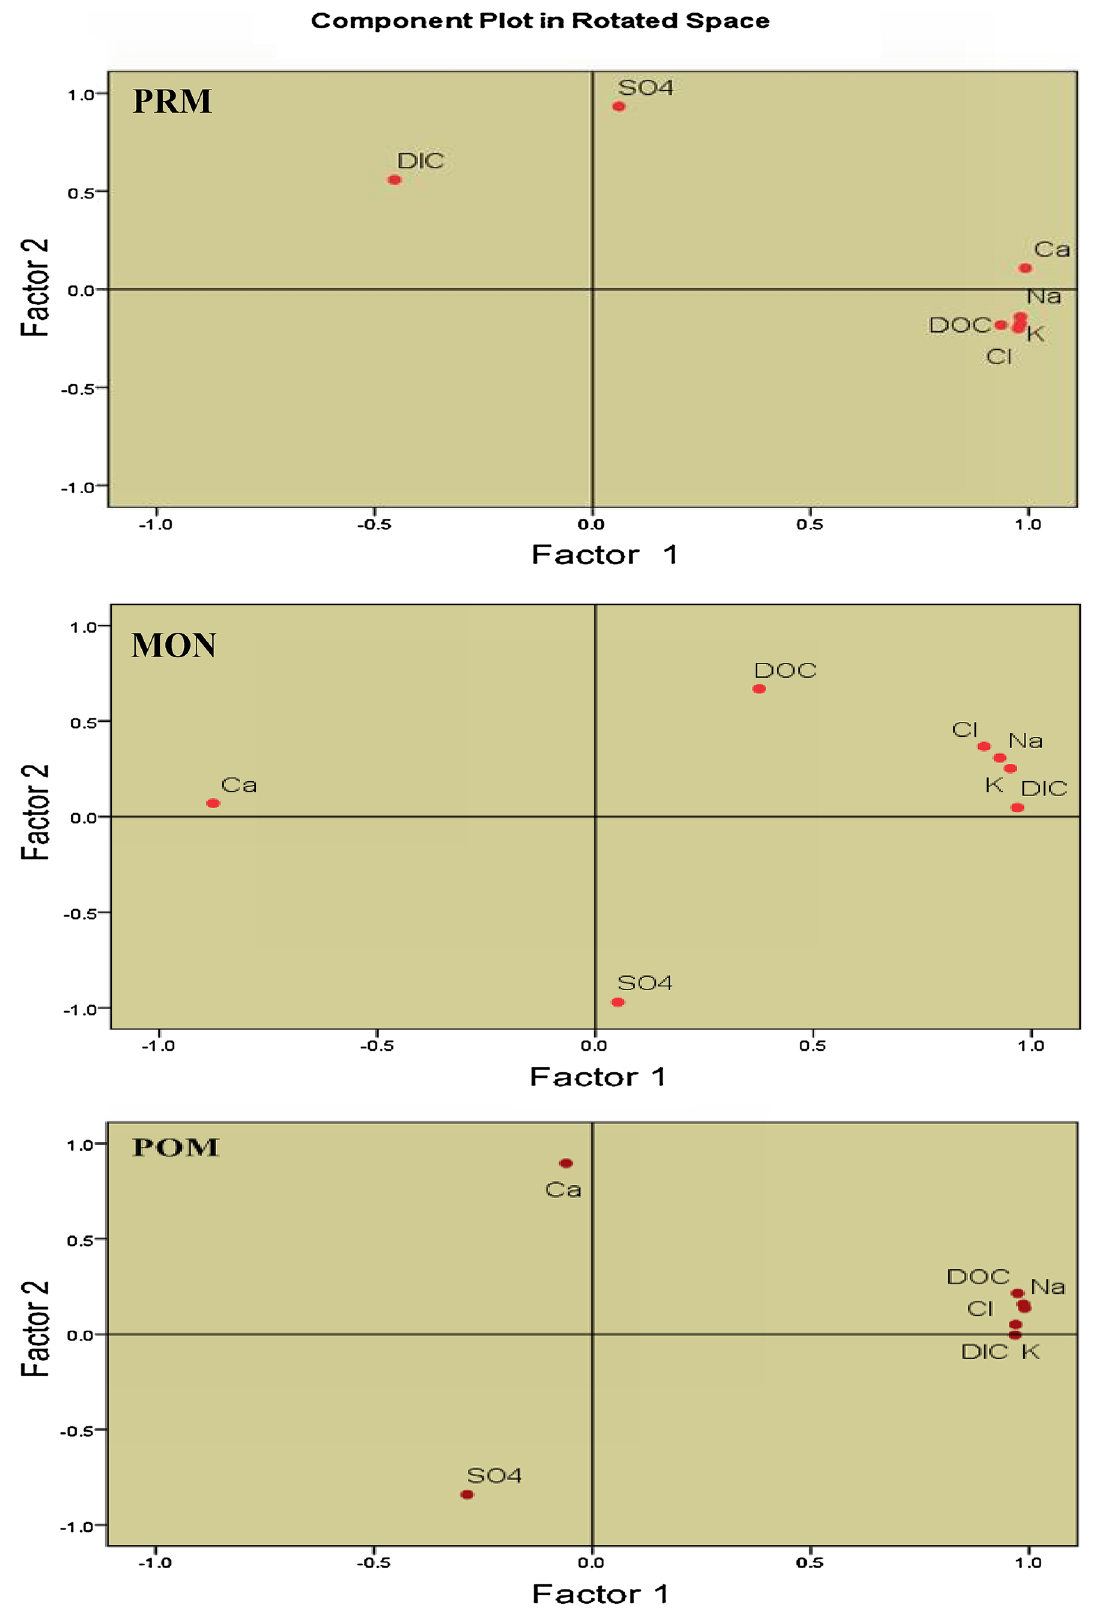
Fig. 7 Factor loading after varimax